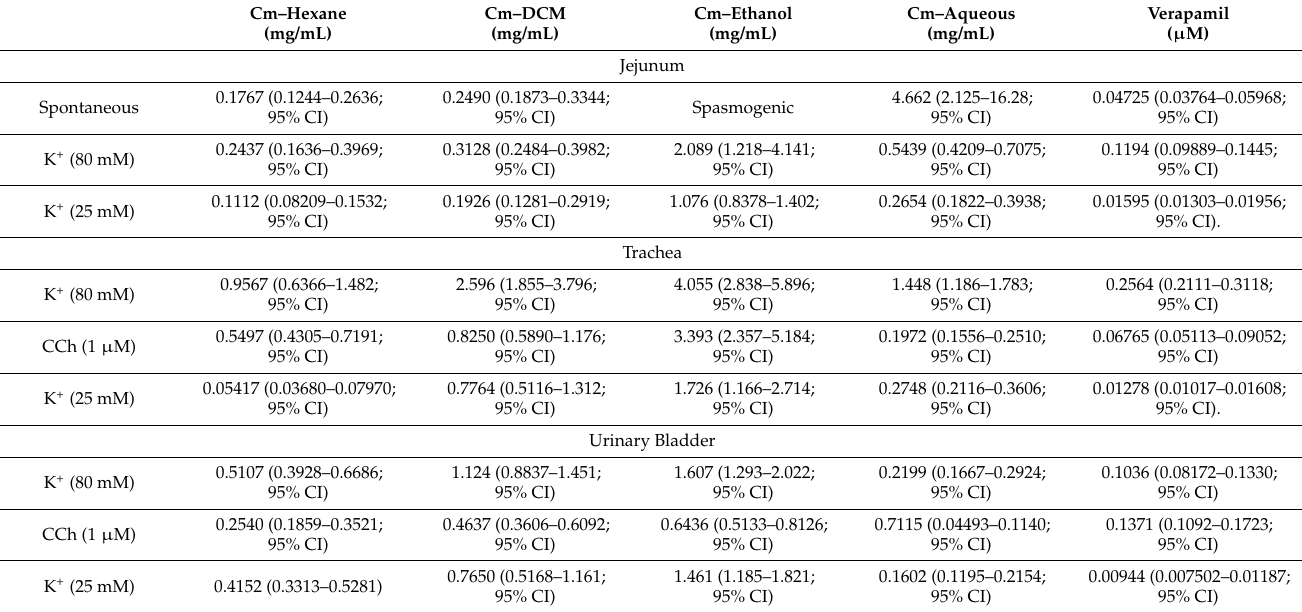
Table 2. The half–maximal effective concentration (EC 50 ) of C. melo seed kernel sequential extracts on isolated tissues